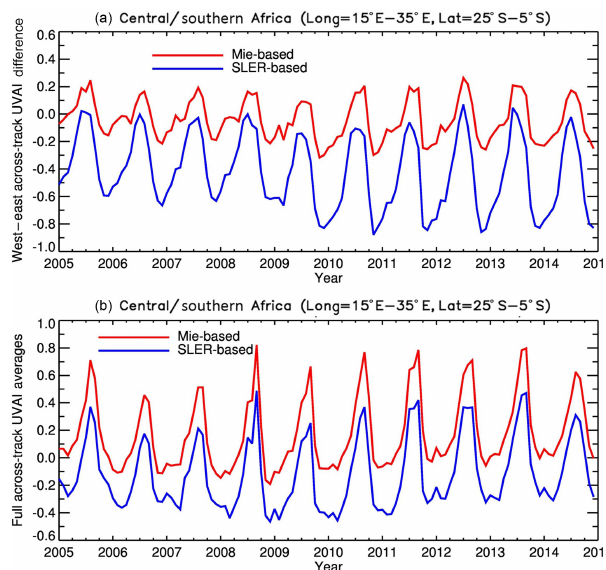
Figure 13. (a) Difference between monthly averages of UVAI cal- culated separately from west and east across-track OMI observa- tions for SLER-based (blue line) and Mie-based (red line) methods over the SAF region. Panel (b) : monthly average UVAI calculated using all available across-track